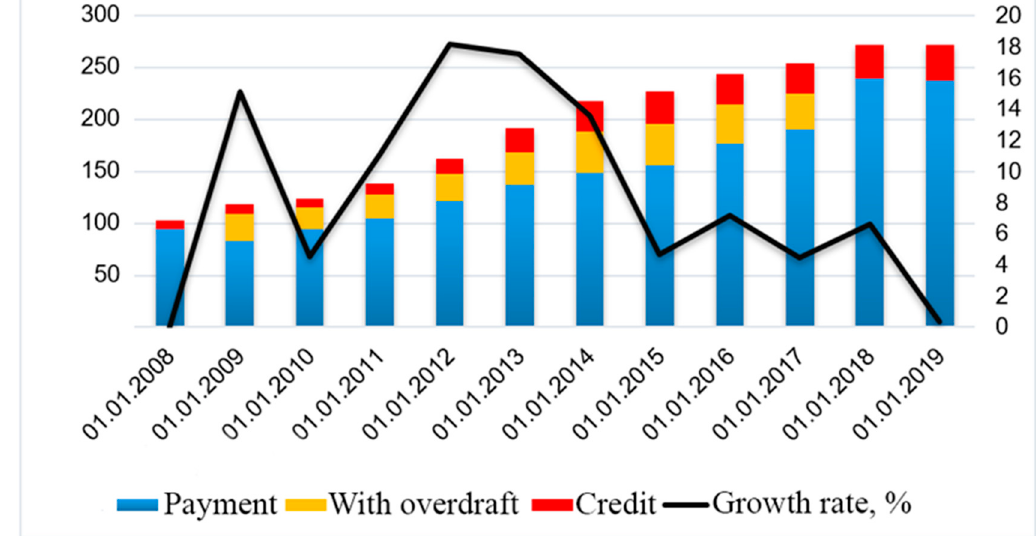
Figure 2. Number of payment cards issued by credit institutions, millions (left scale), percent (right Figure2. Numberofpaymentcardsissuedbycreditinstitutions, millions(leftscale), percent(rightscale). scale). Source: https://www.blockchain.com. Source: https: //